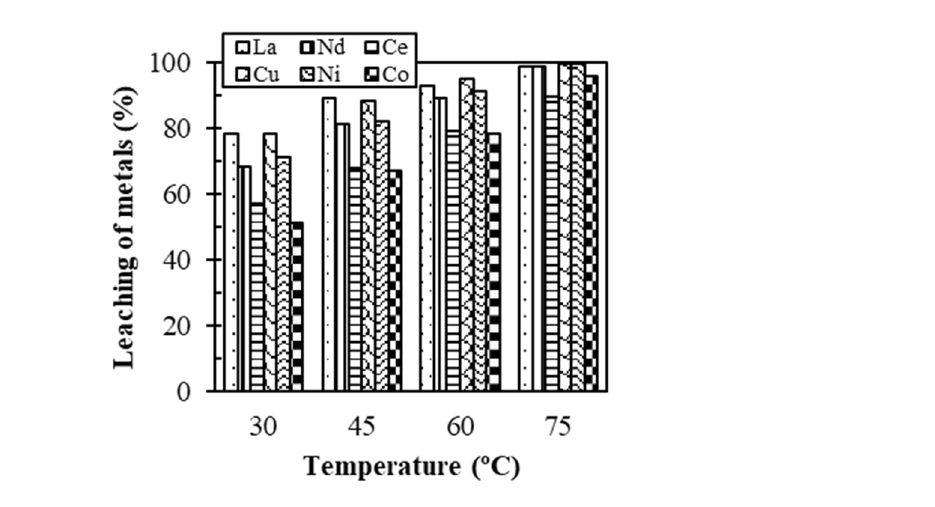
Figure 6. Effect of temperature on leaching of rare earth elements (La, Ce and Nd) and valuable metals (Cu, Ni and Co) [Solid: black powder; liquid: 2 M H 2 SO 4 ; additive: 10% H 2 O 2 ( v / v ); pulp density 100 g/L; time: 60 min]. Figure 7. Effect of pulp density on the leaching of rare earth elements (La, Ce and Nd) and valuable metals (Cu, Ni and Co) [Solid: black powder; liquid: 2 M H 2 SO 4 ; additive: 10% H 2 O 2 ( v / v ); time: 60 min; temperature: 75 °C].